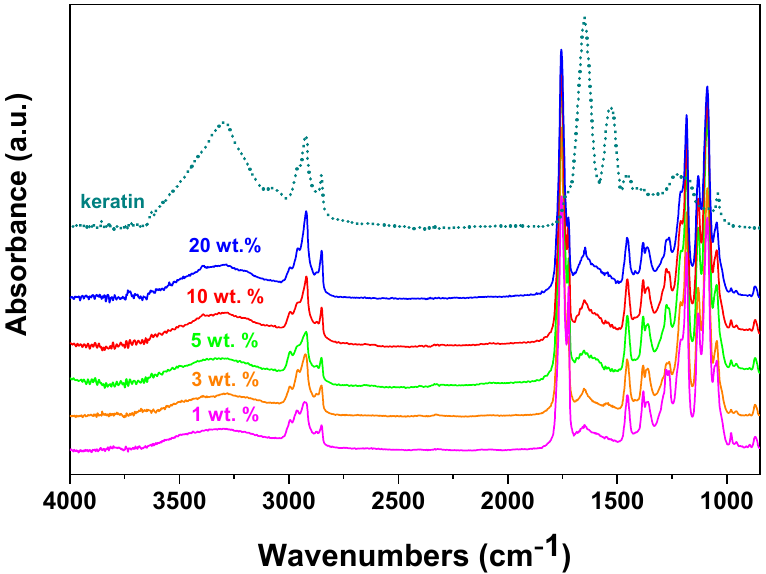
Figure 1. FTIR-ATR spectra analysis of keratin (dotted line) and PLA/PHB/ATBC composites with keratin loading from 1 to 20 wt %. PLA, poly(lactic acid); PHB, poly(3-hydroxybutyrate; ATBC, acetyl tributyl citrate.